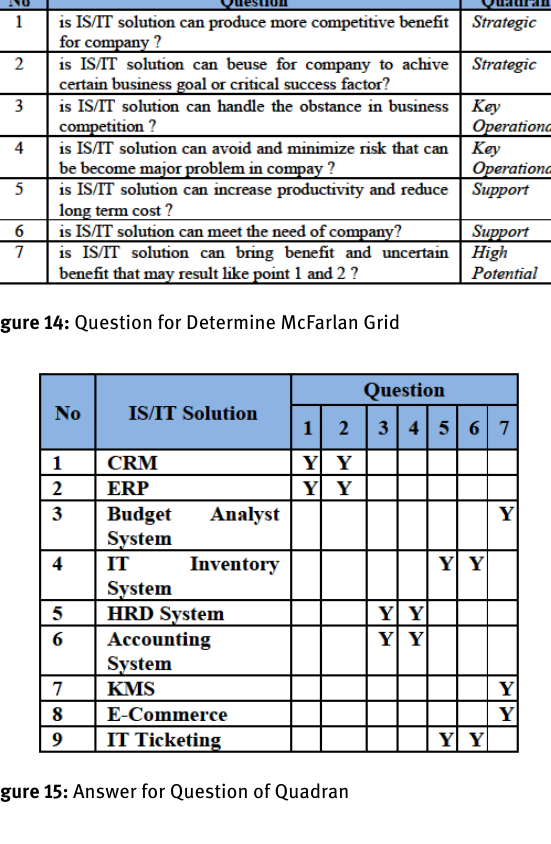
This section discusses the mapping of information sys- tem applications based on their contribution to the com- pany. This application portfolio uses the McFarland matrix whose next step determines the quadrants of each SI solu- tion. McFarland mapping is done based on 4 quadrants, namely: strategic, high potential, key working, and key support.